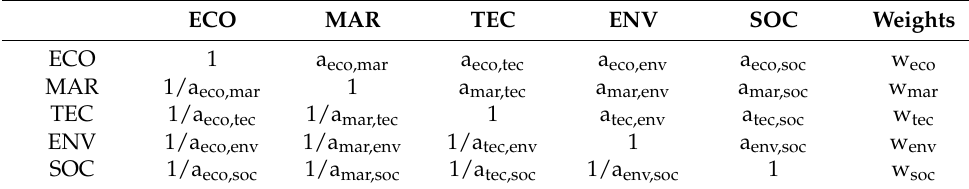
Table 6. Pair-wise comparison matrix of the main